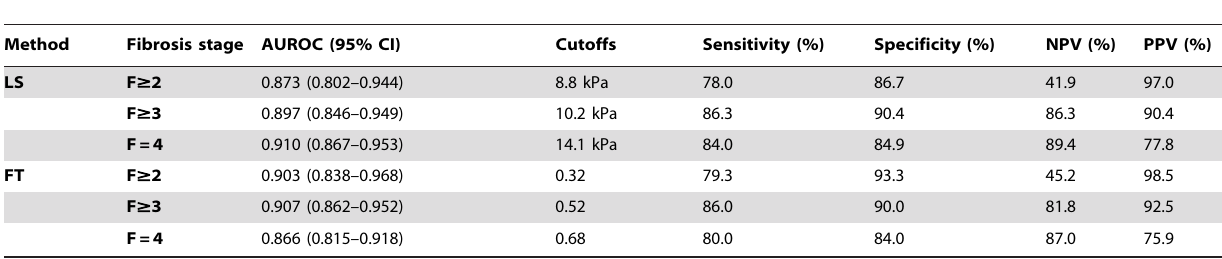
Table 2. Diagnostic performances of LS and FT and their suggested optimal cutoff values.